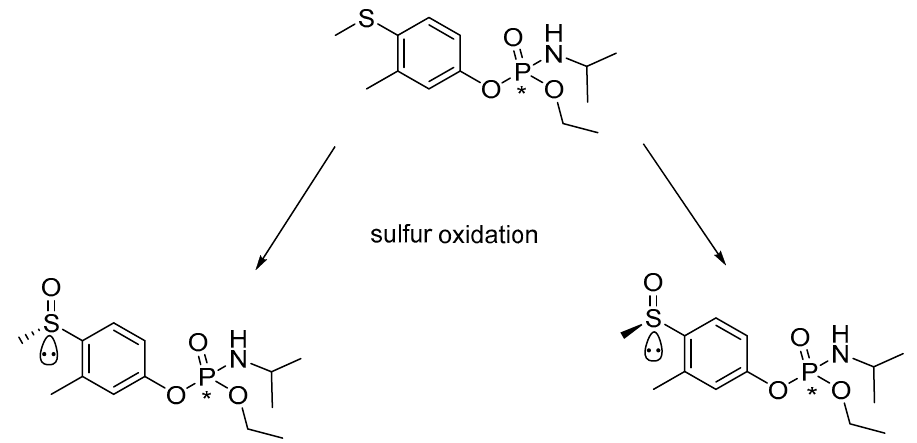
Figure 3. Fenamiphos (bottom) in vivo oxidation and additional sulfur chiral center formation (* denotes the chiral centers).